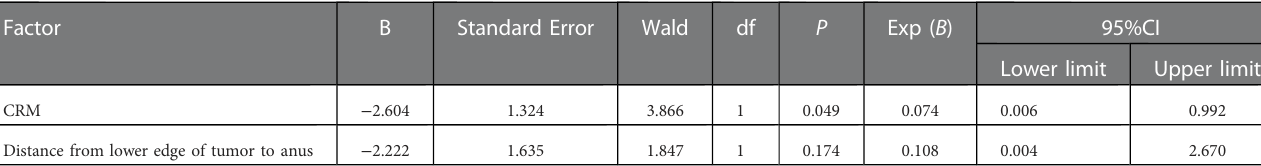
Distance from lower edge of tumor to